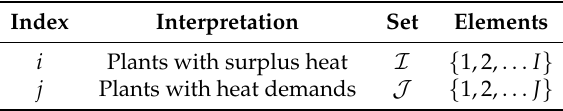
Table 1. Sets and